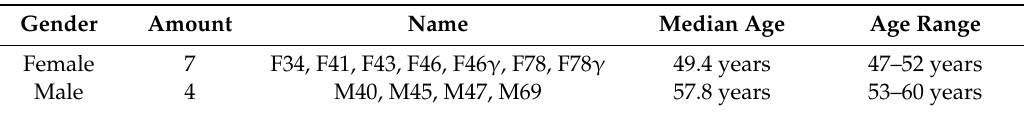
Table 1. Samples for human donors. Letters F (female) or M (male) indicate the donor gender, while numbers are referred to the batch record of processed tissues. Samples indicated by the letter “ γ ” were subjected to sterilization with gamma